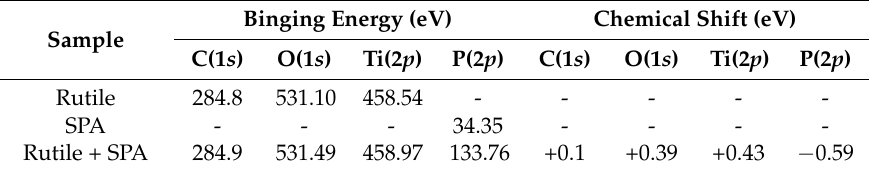
Table 3. Binding energy of elements on the rutile surface before and after SPA adsorbing.